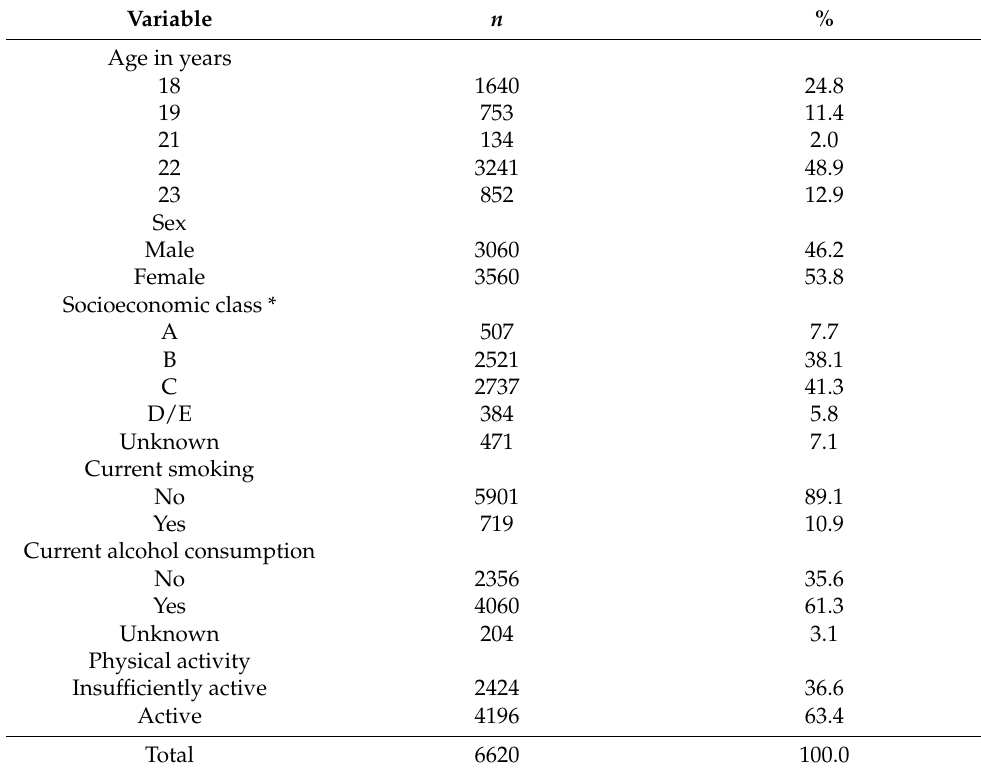
Table 1. Sociodemographic characteristics and life habits of young people of the RPS Brazilian Birth Cohorts Consortium (Ribeir ã o Preto, Pelotas and S ã o Lu í s). Ribeir ã o Preto 2016/2017, Pelotas 2015/2016, and S ã o Lu í s 2016. Variable